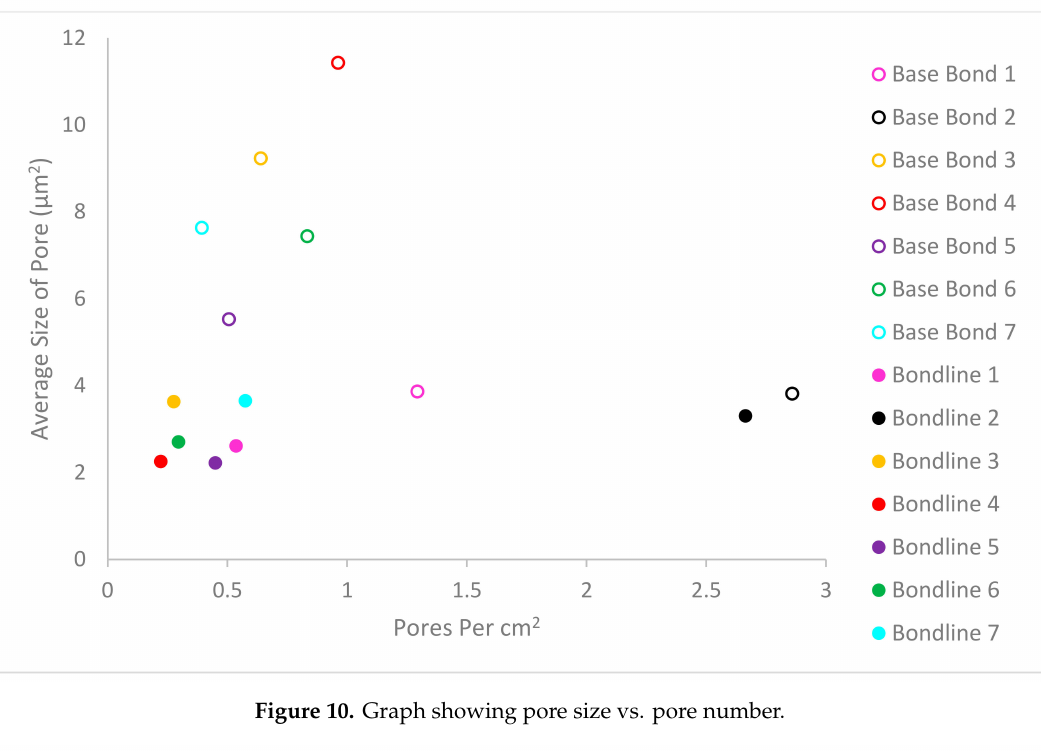
Figure 10. Graph showing pore size vs. pore number.